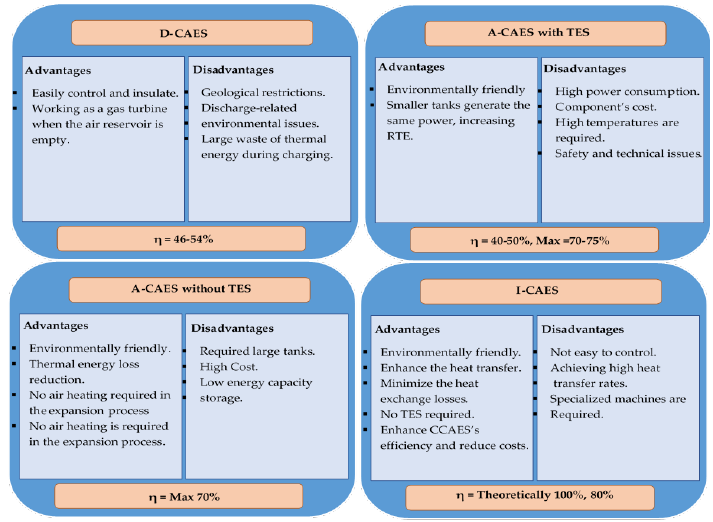
Figure 12. Main advantages and disadvantages of the CAES classifications. Even when CAES is integrated with intermittent renewables and operates under off- design conditions, the integrated system may not operate at its peak performance without the optimal performance of its key